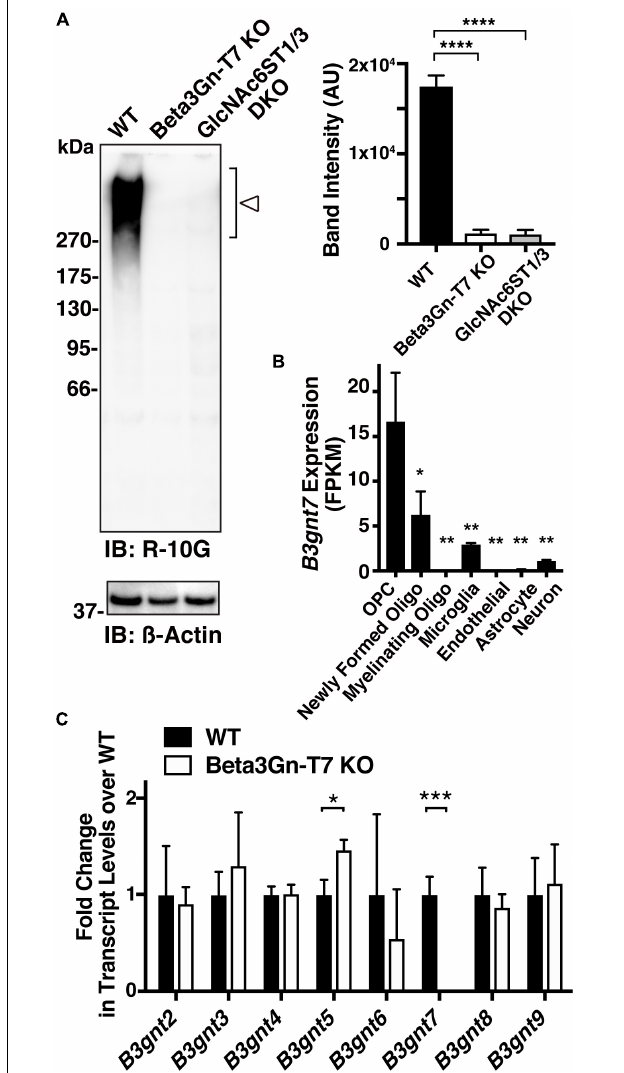
FIGURE 2 | Beta3Gn-T7 is a major brain keratan sulfate β 1,3 N -acetylglucosaminyltransferase in the cerebral cortex of adult mice. (A) Expression of the R-10G keratan sulfate epitope in the 1% Triton-soluble fractions prepared from the cerebral cortices of adult WT, Beta3Gn-T7 KO, and GlcNAc6ST1 and GlcNAc6ST3 double-deficient knockout (DKO) mice. GlcNAc6ST1 and GlcNAc6ST3 DKO were used as a negative control, since